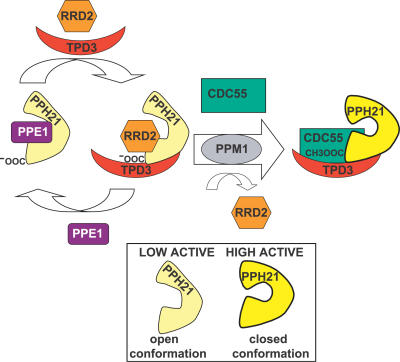
Model: RRD/PTPA-Dependent Generation of Active PP2A C Subunit Is Coupled to Holoenzyme Assembly and Regulated by Methyl-Esterase/Transferase Enzymes